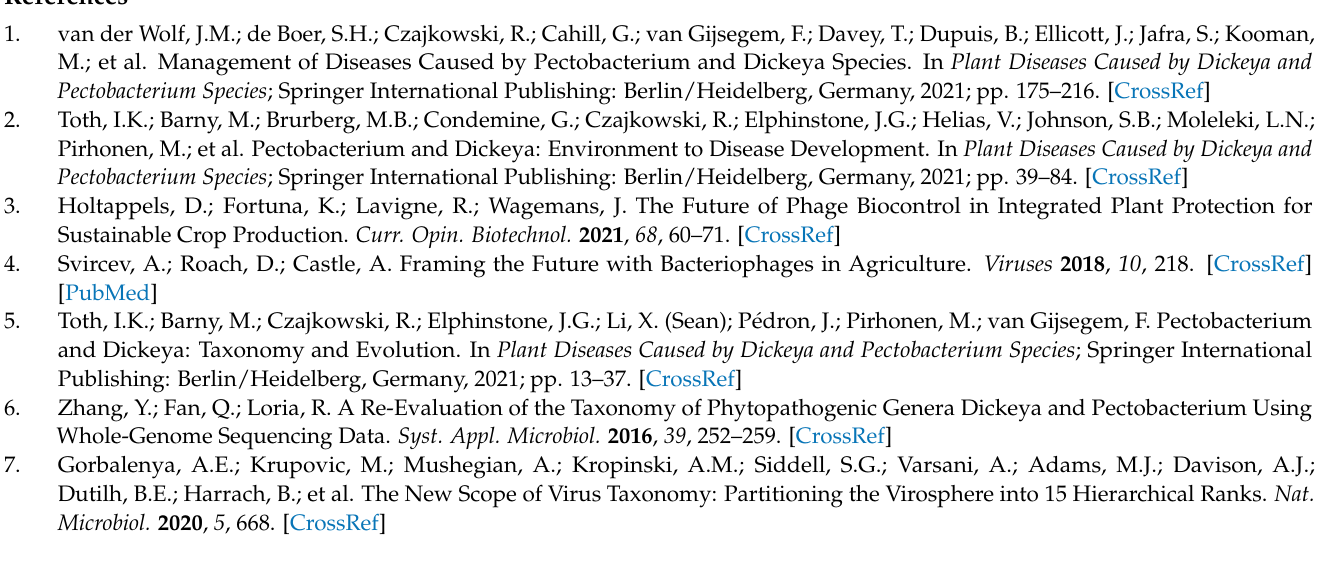
of 1000 replicates. The scale bar shows 0.2 estimated substitutions per site and the tree was unrooted. Figure S9: VIRIDIC generated heatmap of Autographiviridae phages. The colour coding indicates the clustering of the phage genomes based on intergenomic similarity. The numbers represent the similarity values for each genome pair, rounded to the first decimal. Figure S10: VIRIDIC generated heatmap of Schitoviridae phages. The colour coding indicates the clustering of the phage genomes based on intergenomic similarity. The numbers represent the similarity values for each genome pair, rounded to the first decimal. Figure S11: VIRIDIC generated heatmap of Kafunavirus and related phages. The colour coding indicates the clustering of the phage genomes based on intergenomic similarity. The numbers represent the similarity values for each genome pair, rounded to the first decimal. Figure S12: Best-scoring tree found by RAxML, based on the terminase large subunit amino acid sequences of Kafunavirus and related phages. Taxonomic classification was taken from ICTV and NCBI sequence attributes and is shown to the right of the phage name. Bootstrap support values are shown above their branch as a percentage of 1000 replicates. The scale bar shows 0.2 estimated substitutions per site and the tree was unrooted. Figure S13: Best-scoring tree found by RAxML, based on the major capsid protein amino acid sequences of Kafunavirus and related phages. Taxonomic classification was taken from ICTV and NCBI sequence attributes and is shown to the right of the phage name. Bootstrap support values are shown above their branch as a percentage of 1000 replicates. The scale bar shows 0.2 estimated substitutions per site and the tree was unrooted. Figure S14: VIRIDIC generated heatmap of Pectobacterium phage DU_PP_III and related phages. The colour coding indicates the clustering of the phage genomes based on intergenomic similarity. The numbers represent the similarity values for each genome pair, rounded to the first decimal.Table S1: Genomic properties of 108 SRP bacteriophages published in the GenBank genome database, as of July